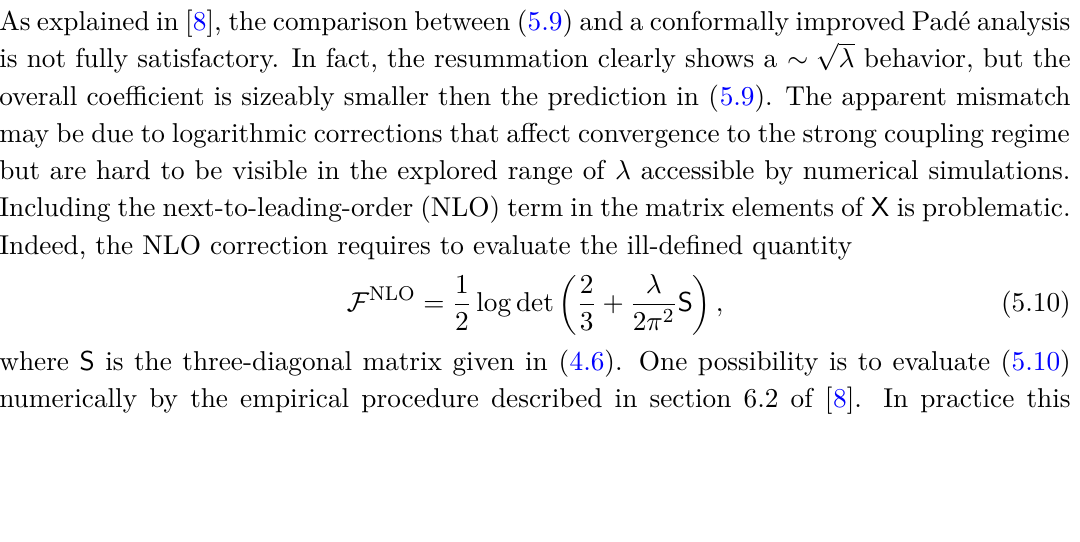
Figure 4 . Padé curve (red curve), MC data and the large- λ theoretical prediction for γ 3 = 1 + ∆ 1 ( λ ) (black dashed curve) in the range 1000 π 2 ≤ λ ≤ 4000 π 2 . As N increases, the MC points systematically tend towards the Padé